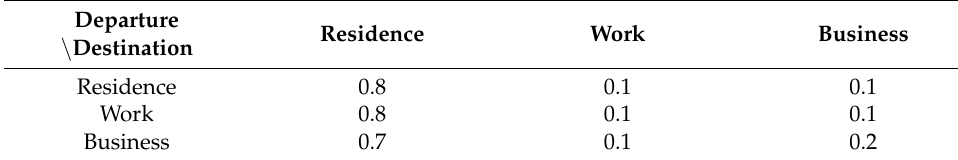
Table 1. OD matrix at 22:00~7:00 (+1) on weekdays. Departure